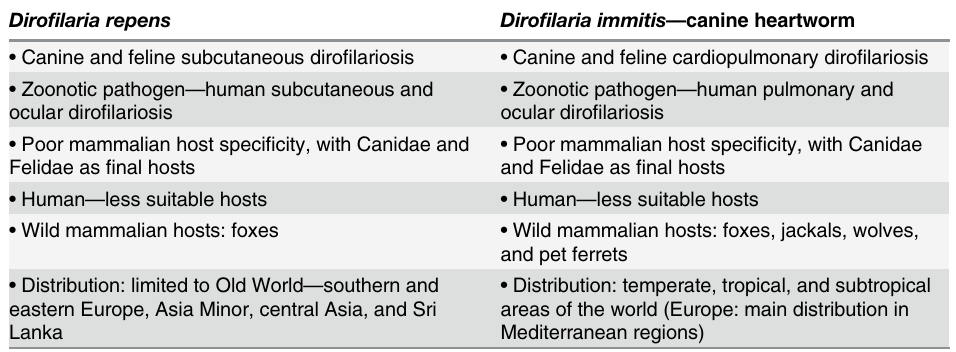
Table 1. Comparison of Dirofilaria repens and D . immitis